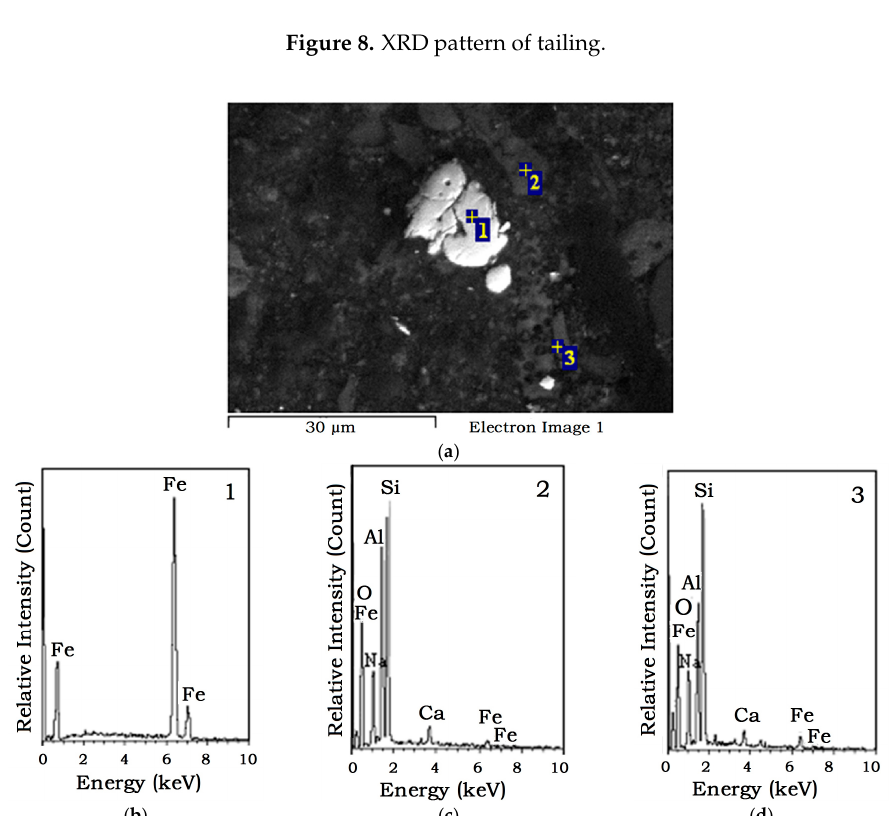
Figure 9. ( a ) SEM image of tailing, ( b ) EDS image of point 1; ( c ) EDS image of point 2 and ( d ) EDS image of point 3.